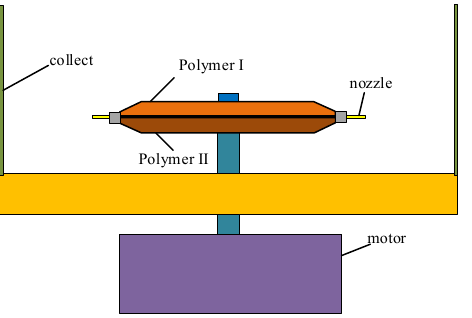
Figure 1. Schematic illustration of the planar structure of high-speed centrifugal spinning device. In the early stages of hydrodynamic development, a few simple experimental obser- vations were consistent with the assumption of no slip, so the slip phenomenon received lile further aention. In recent years, with the rapid development of nanofabrication